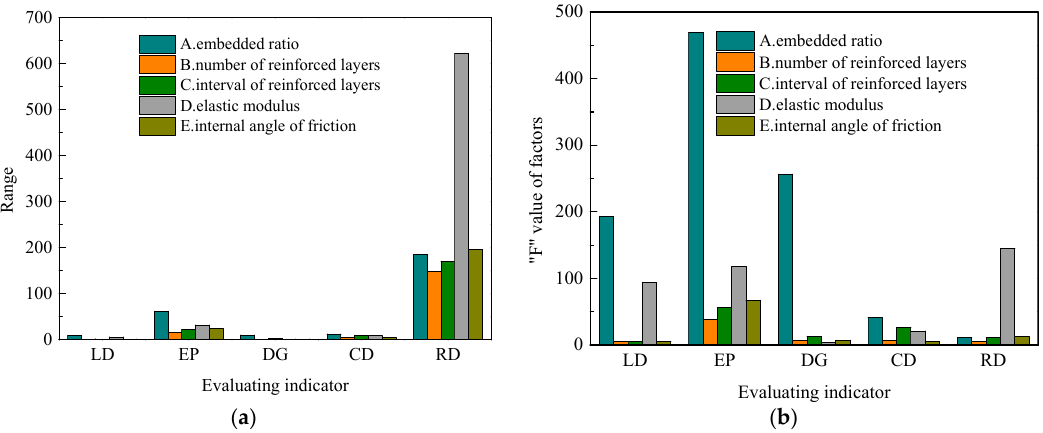
Figure 11. Range analysis and variance analysis of the lateral displacement, lateral earth pressure, deflection of the first reinforced layer, crater depth, and effective reinforced depth: ( a ) Range analysis; ( b ) “F” value of factors.